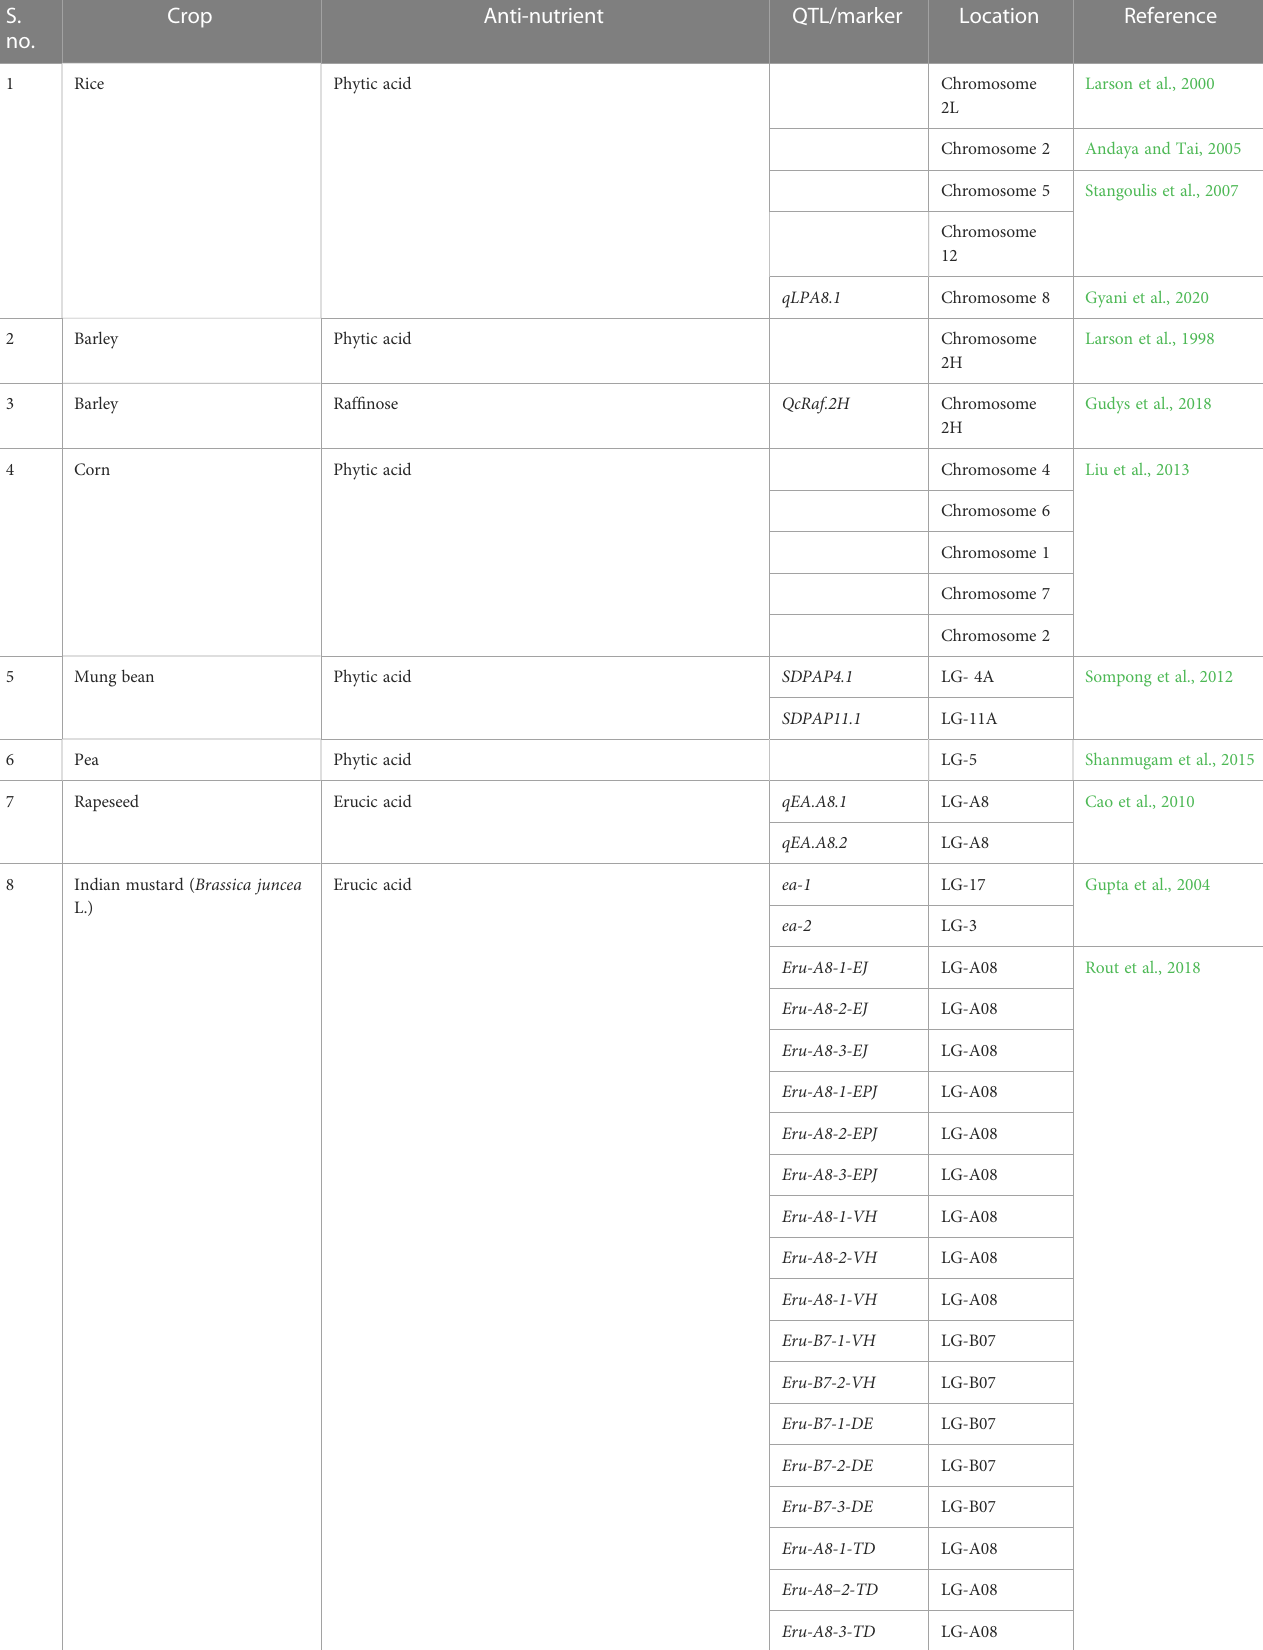
TABLE 3 Summary of the major QTL ’ s observed for the anti-nutrients in crops. S.